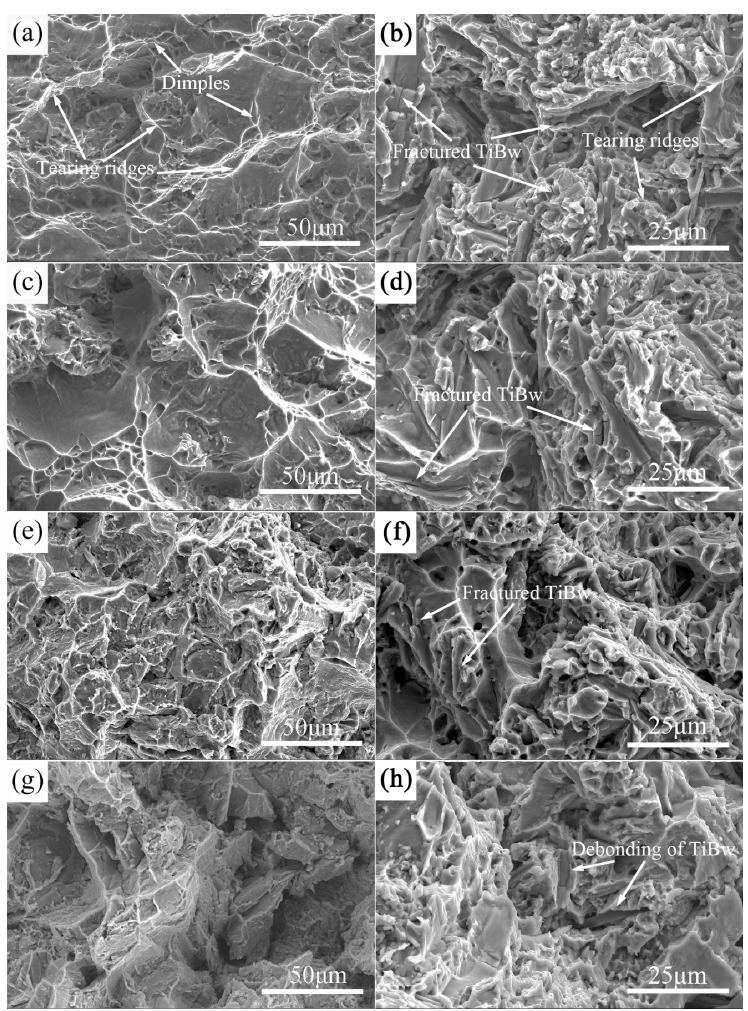
Figure 9. High-temperature SEM fracture of as-sintered monolithic TA15 alloy at 400 °C ( a ); 500 °C ( c ); 600 °C ( e ) and 700 °C ( g ); and of 5 vol % TiBw/TA15 composites at 400 °C ( b ); 500 °C ( d ); 600 °C ( f ); and 700 °C ( h ).